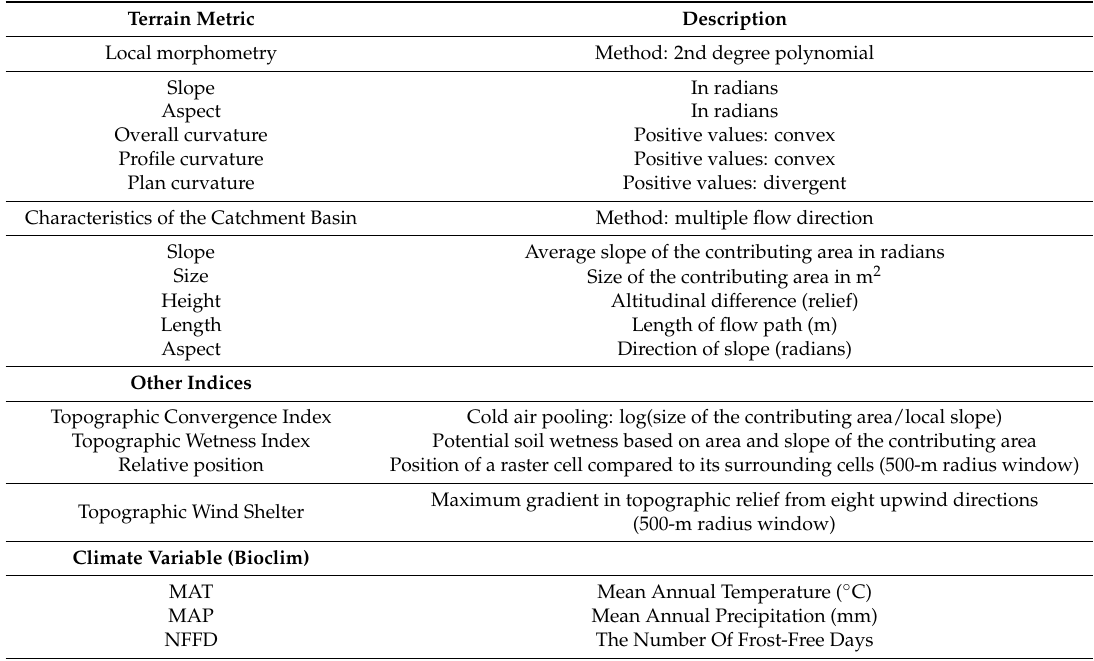
Table 1. Spatial variables used to characterize the refugial environment, including terrain metrics derived from a 30-m DEM (calculations were done using R raster [52] and RSAGA [54]) and climate variables mapped at 1-km resolution [51].